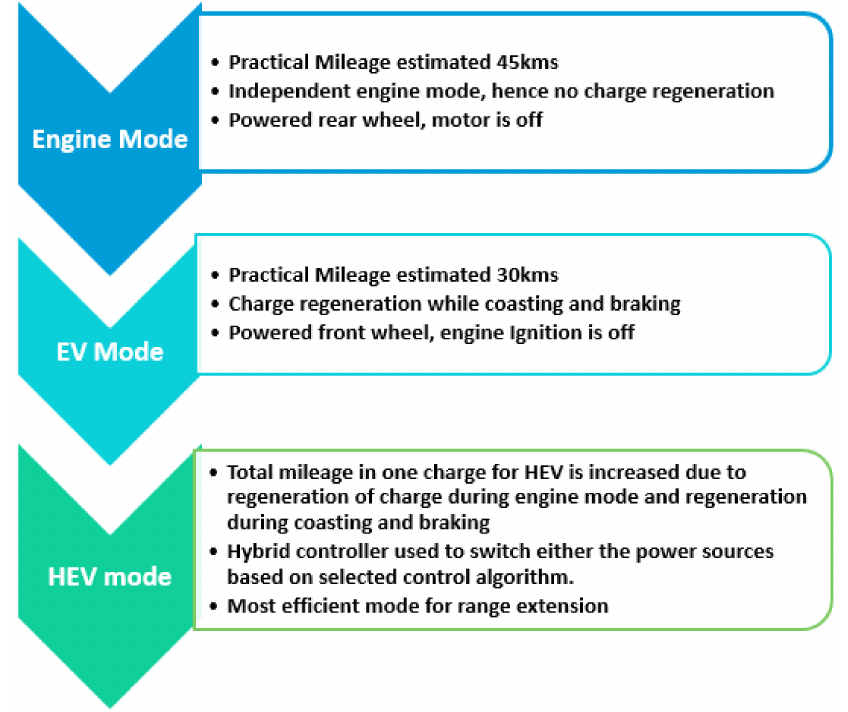
Figure 13. The switching mode highlights for testing